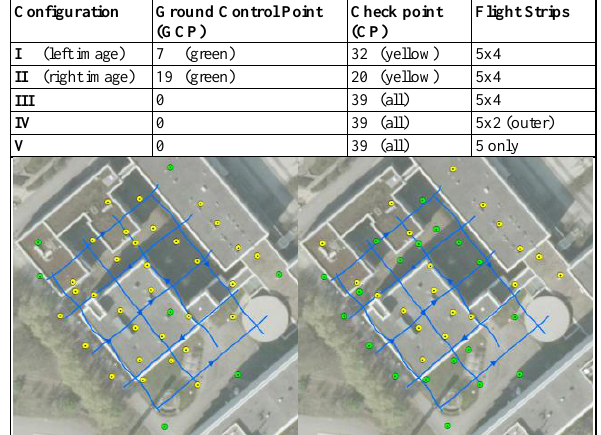
Table 2: Chosen configurations for aerial triangulations considering several distributions of GCP’s, CP’s and flight lines